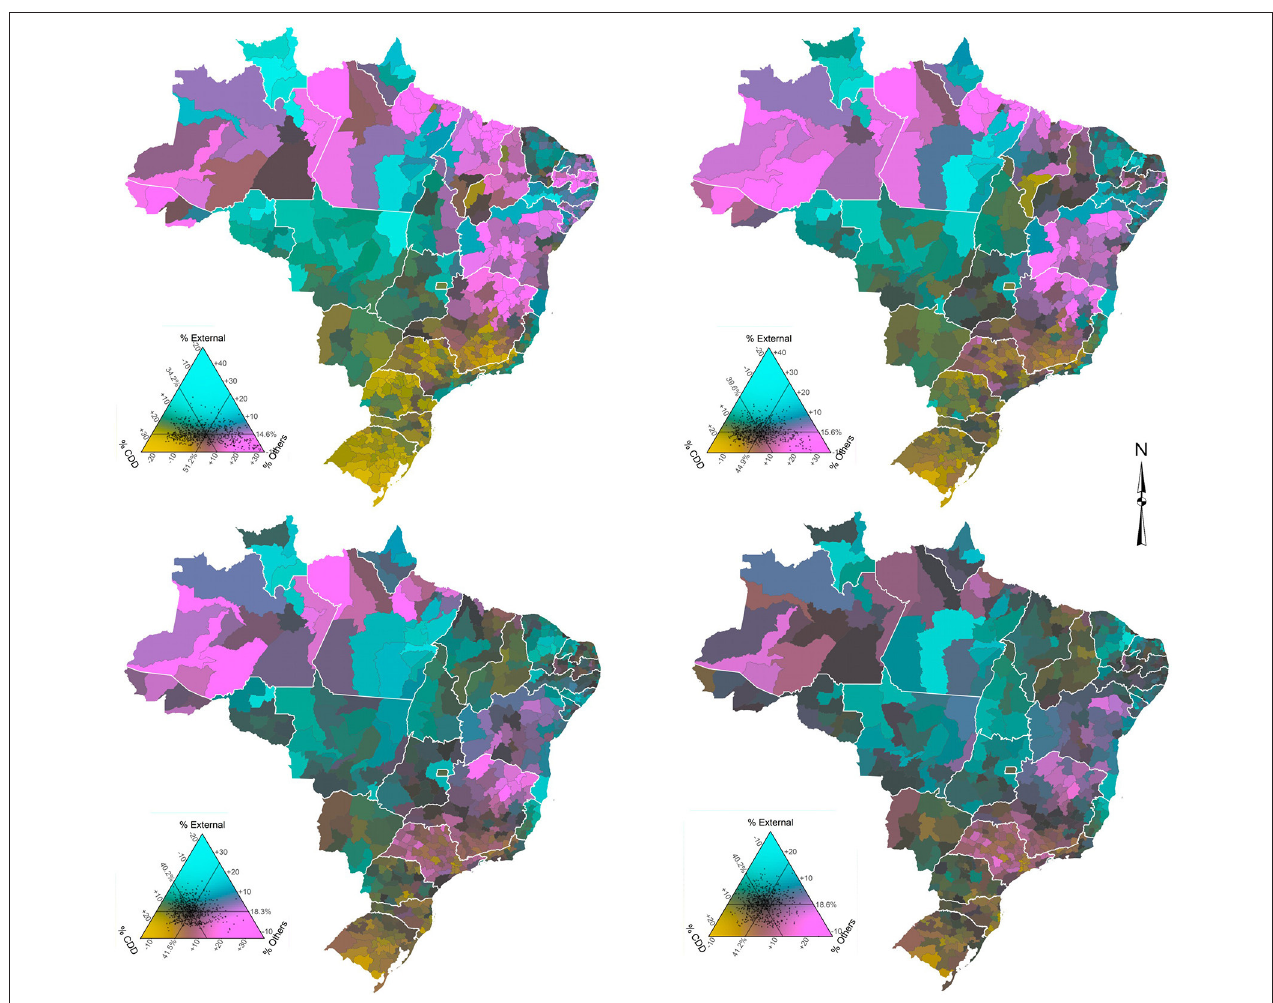
FIGURE 2 | Distribution of groups of causes of death by micro-regions, males, Brazil - time series 1998–2002 (top left), 2003–2007 (top right), 2008–2012 (bottom left), and 2013–2017 (bottom right).